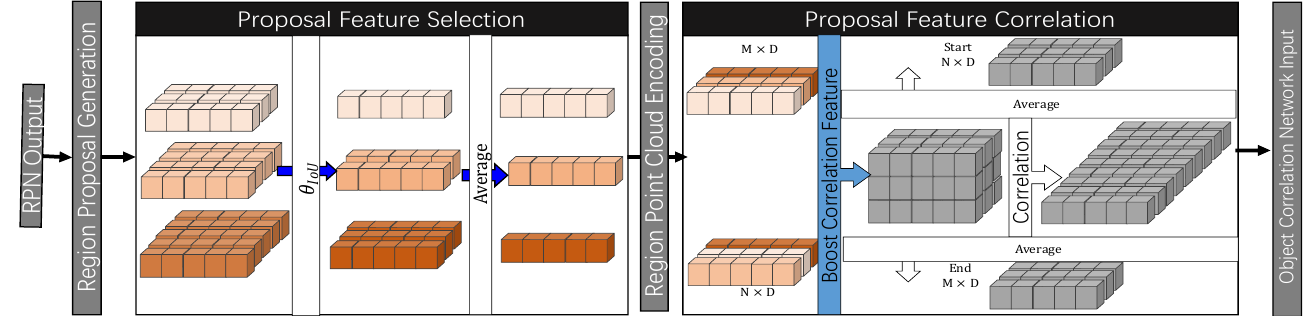
Figure 2. Region proposal processing for training the object correlation network. The input proposal features with the same ID label are shown with the same